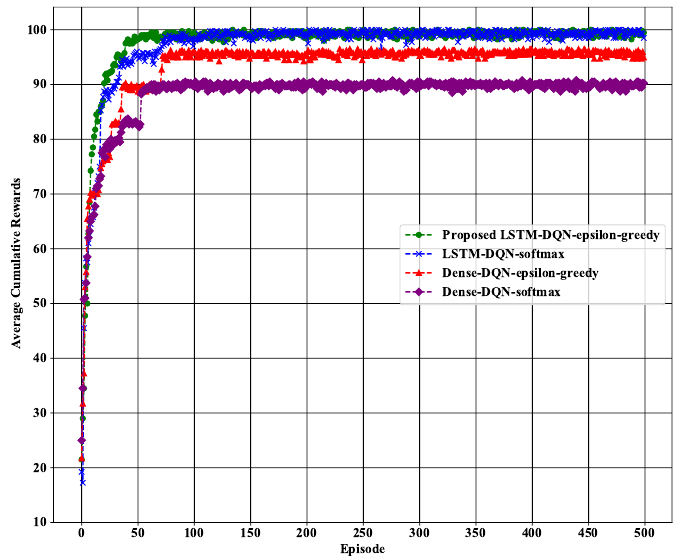
Figure 10. Average cumulative rewards per